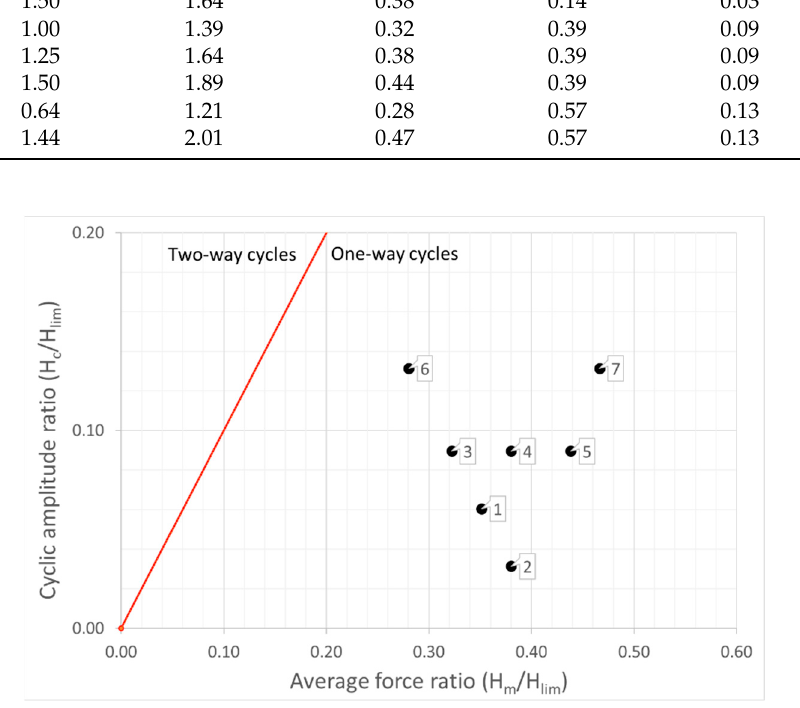
Figure 4. Parametric study under mono-directional cyclic loading: cases